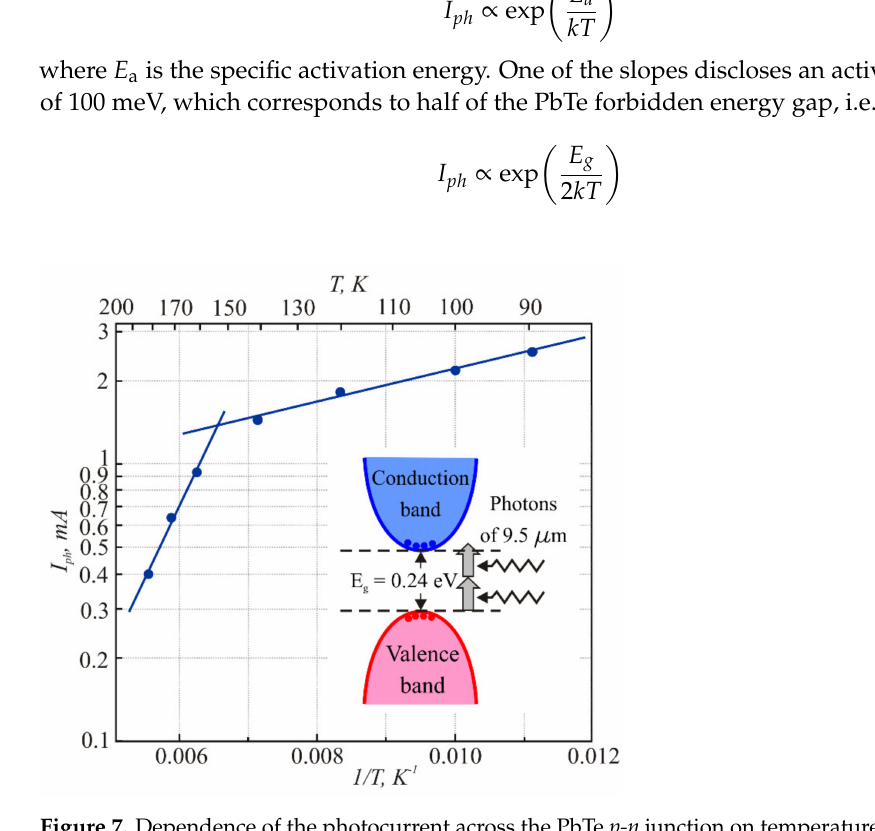
Figure 7. Dependence of the photocurrent across the PbTe p-n junction on temperature. Straight lines are guides for the eye of exponential ranges. In inset: schematic view of the two-photon absorption in PbTe at 150